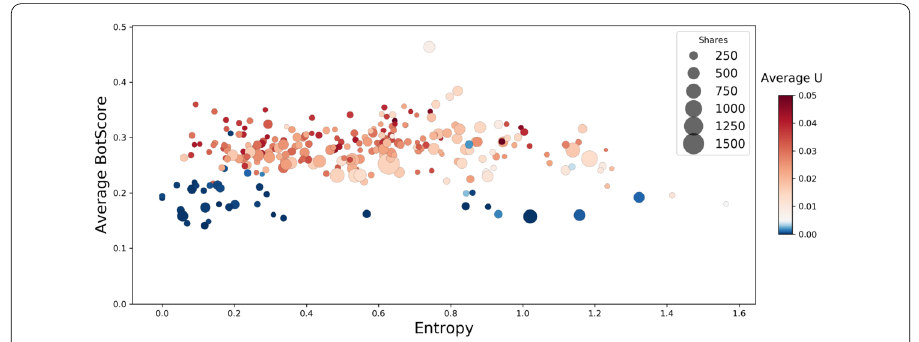
Figure 3 BotScore as a function of the entropy: each dot is a URL. BotScore and Untrustworthiness by URL are computed as the average values of the scores of the users retweeting each URL. Also, dots on the left side of the plot (lower entropy) refer to URLs that have mainly “local” diffusion, while URLs on the right (higher entropy) are spread across many different